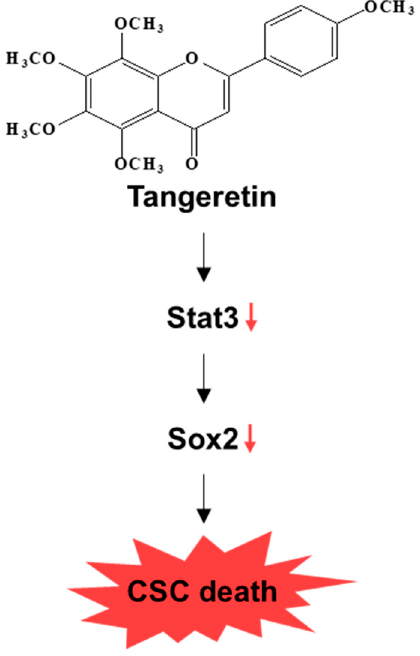
Figure 8. The proposed model for CSC death induced by tangeretin is shown.